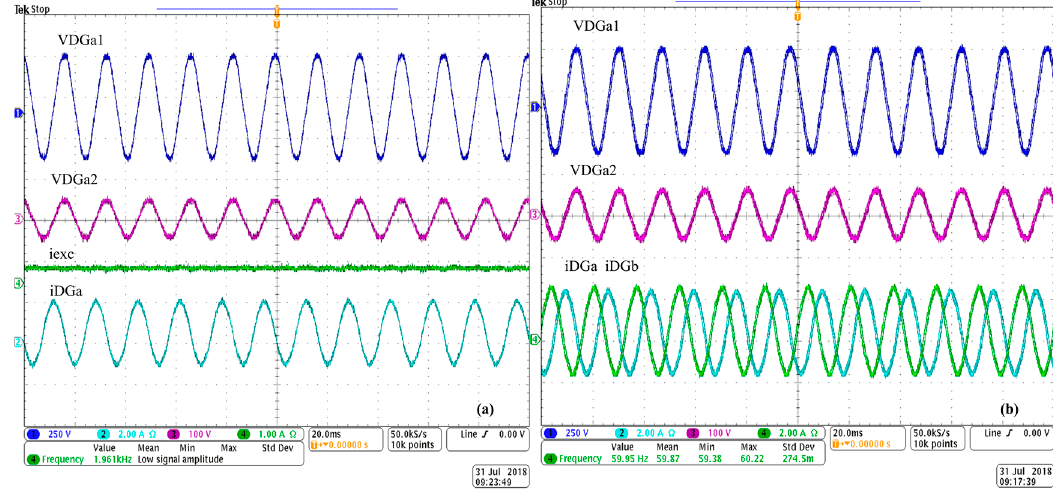
Figure 12. Steady-state performance in the presence of linear loads.